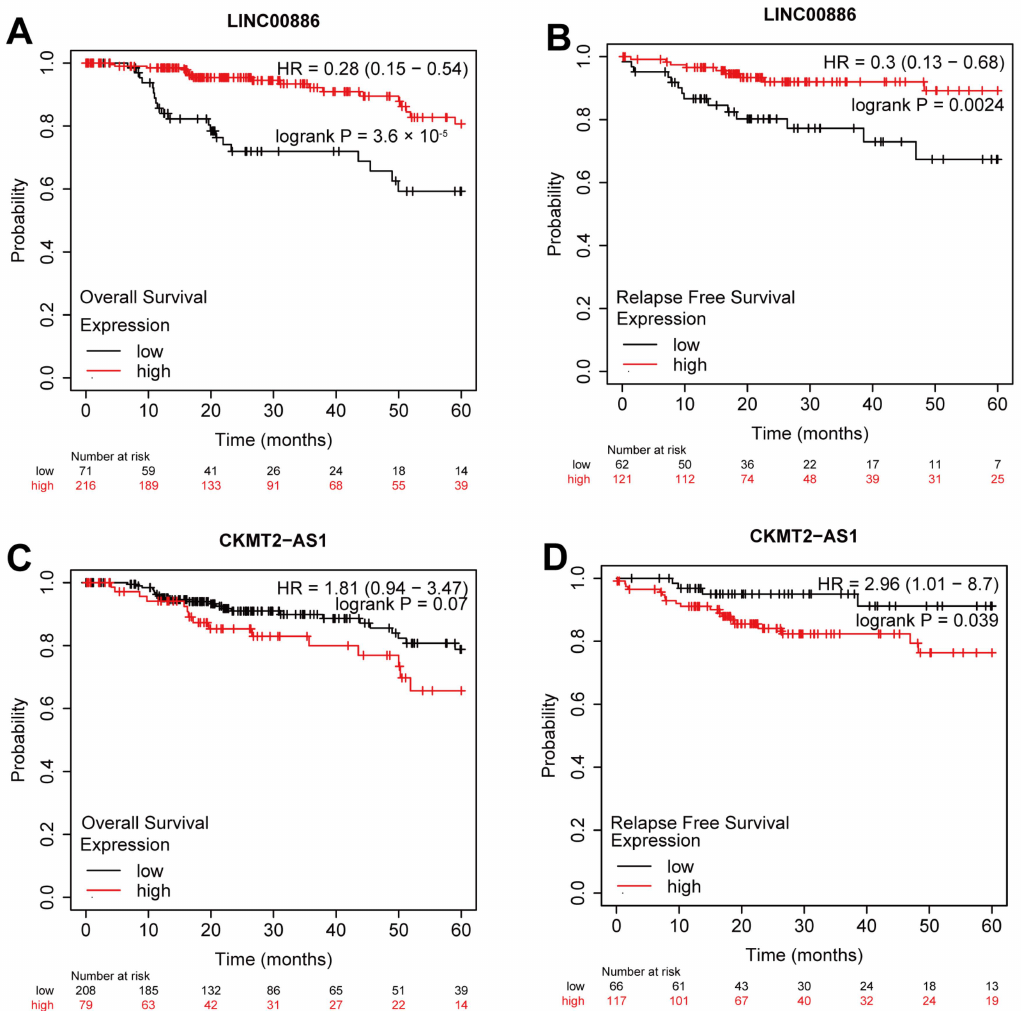
Figure 10. External datasets validation of CRLs as possible biomarkers. Overall survival (OS) and relapse free survival (RFS) analysis of LINC00886 ( A , B ) and CKMT2-AS1 ( C , D ) from the Kaplan– Meier Plotter